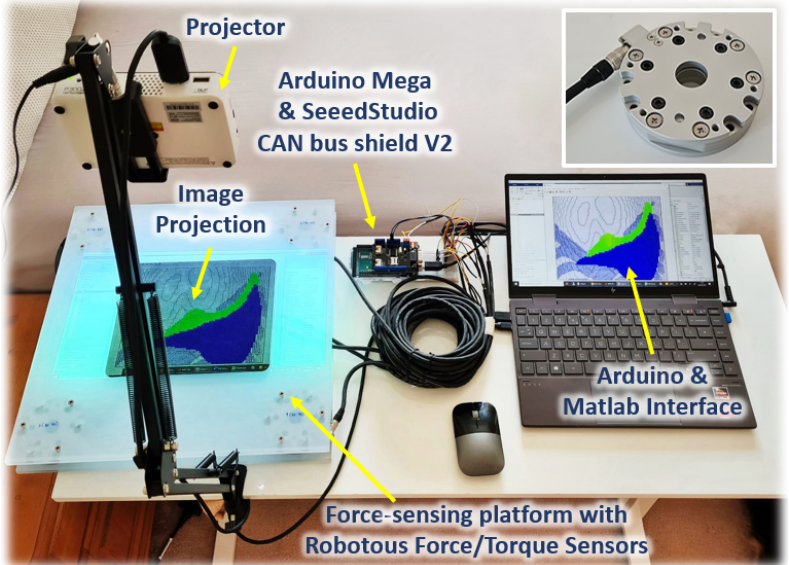
Figure 7. The overall hardware integration, with the 2D image of the surrogate model projected onto the force-sensing platform which is equipped with a Robotous 6-axis force/torque sensor (inset, top right corner) at each corner of the platform to obtain real-time force and position